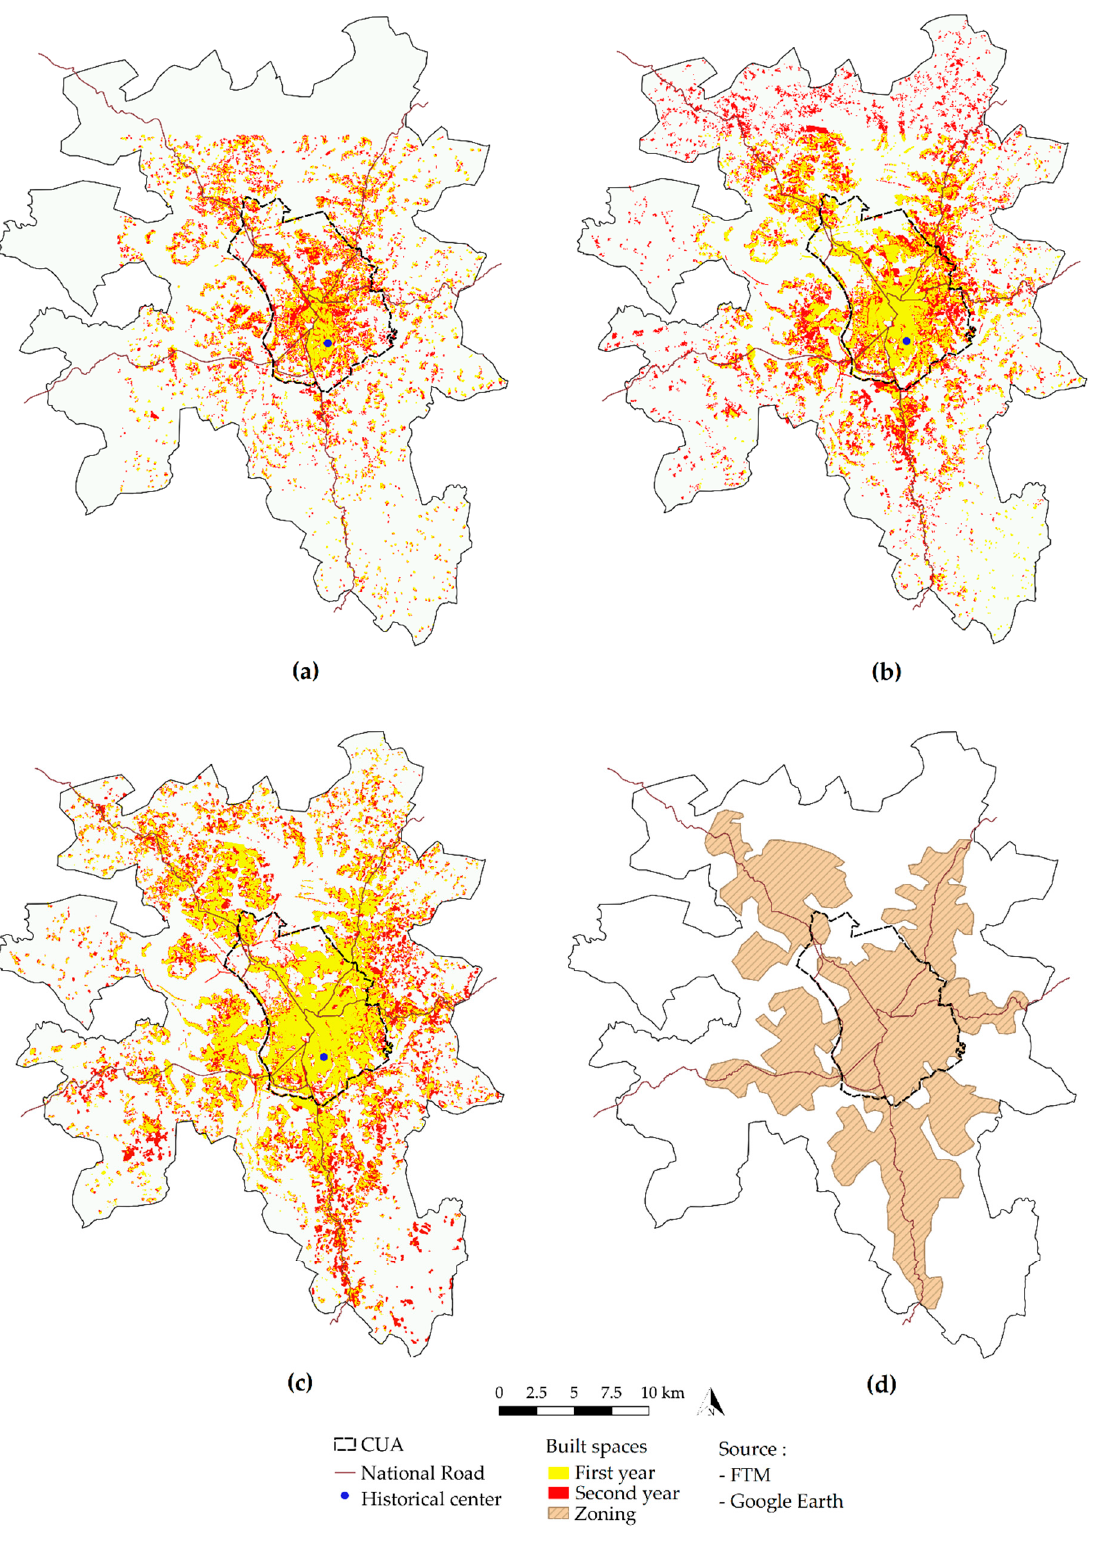
Figure 8. Urbanized cells: ( a ) 1953–1975; ( b ) 1975–2006; ( c ) 2006–2017; ( d ) 2017. Under the French regime, the extent of this encroachment became more important, and Antananarivo underwent its first major urban transformations. Some 20 hectares were backfilled in order to form the first Fokontany in the “lower town”, and other new neighborhoods were created [54,55]. Between 1896 and 1903, 35 km of paved roadways